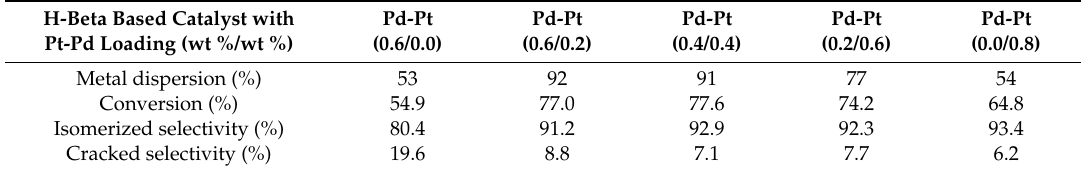
Table 3. Metal dispersion, n -hexadecane conversion, and isomerized selectivity/cracked selectivities of Pd-Pt/H-Beta catalysts with various Pt and Pd loadings. Reaction conditions: T = 200 ◦ C, P = 1